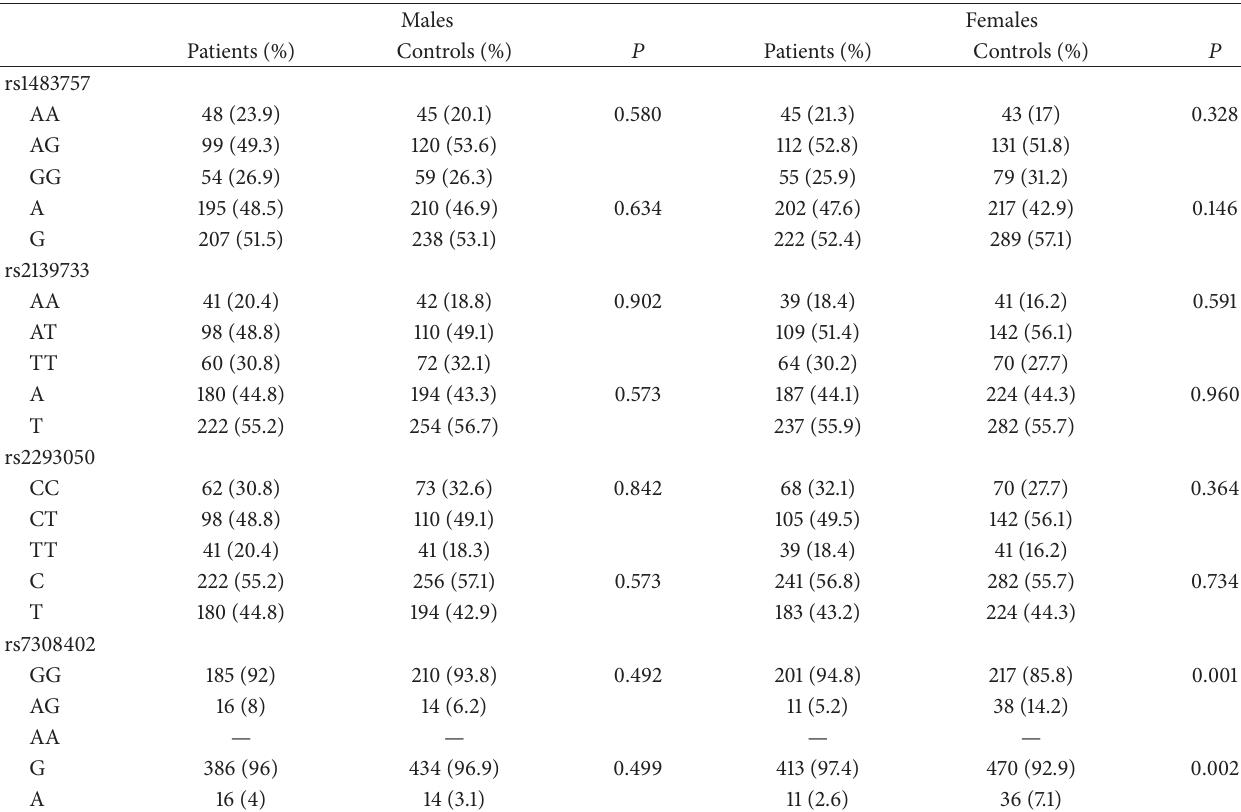
Table 3: Genotype and allele frequency in males and females.